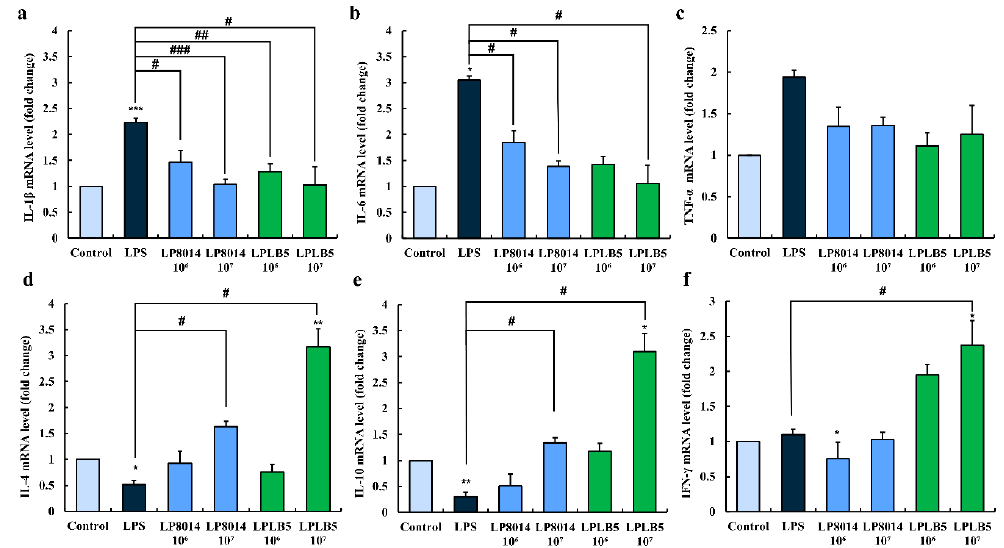
Figure 10. Effects of LPLB5 and L. plantarum ATCC 8014 (LP8014) on the mRNA expression levels of ( a – c ) pro-inflammatory cytokines (IL-1 β , IL-6, and TNF- α ) and ( d – f ) anti-inflammatory cytokines (IL-4, IL-10, and IFN- γ ) in LPS-stimulated Caco-2 cells. Cells were pretreated with Dulbecco’s modified Eagle medium (DMEM), LPLB5, or L. plantarum ATCC 8014 (10 6 and 10 7 CFU/mL) for 6 h and then stimulated with LPS for 2 h. The results represent the mean ± SEM, with n = 3. * indicates a significant di ff erence vs. control (* p < 0.05, ** p < 0.01, *** p < 0.001) and # indicates a significant di ff erence vs. LPS-treated group (# p < 0.05, ## p < 0.01, ### p <